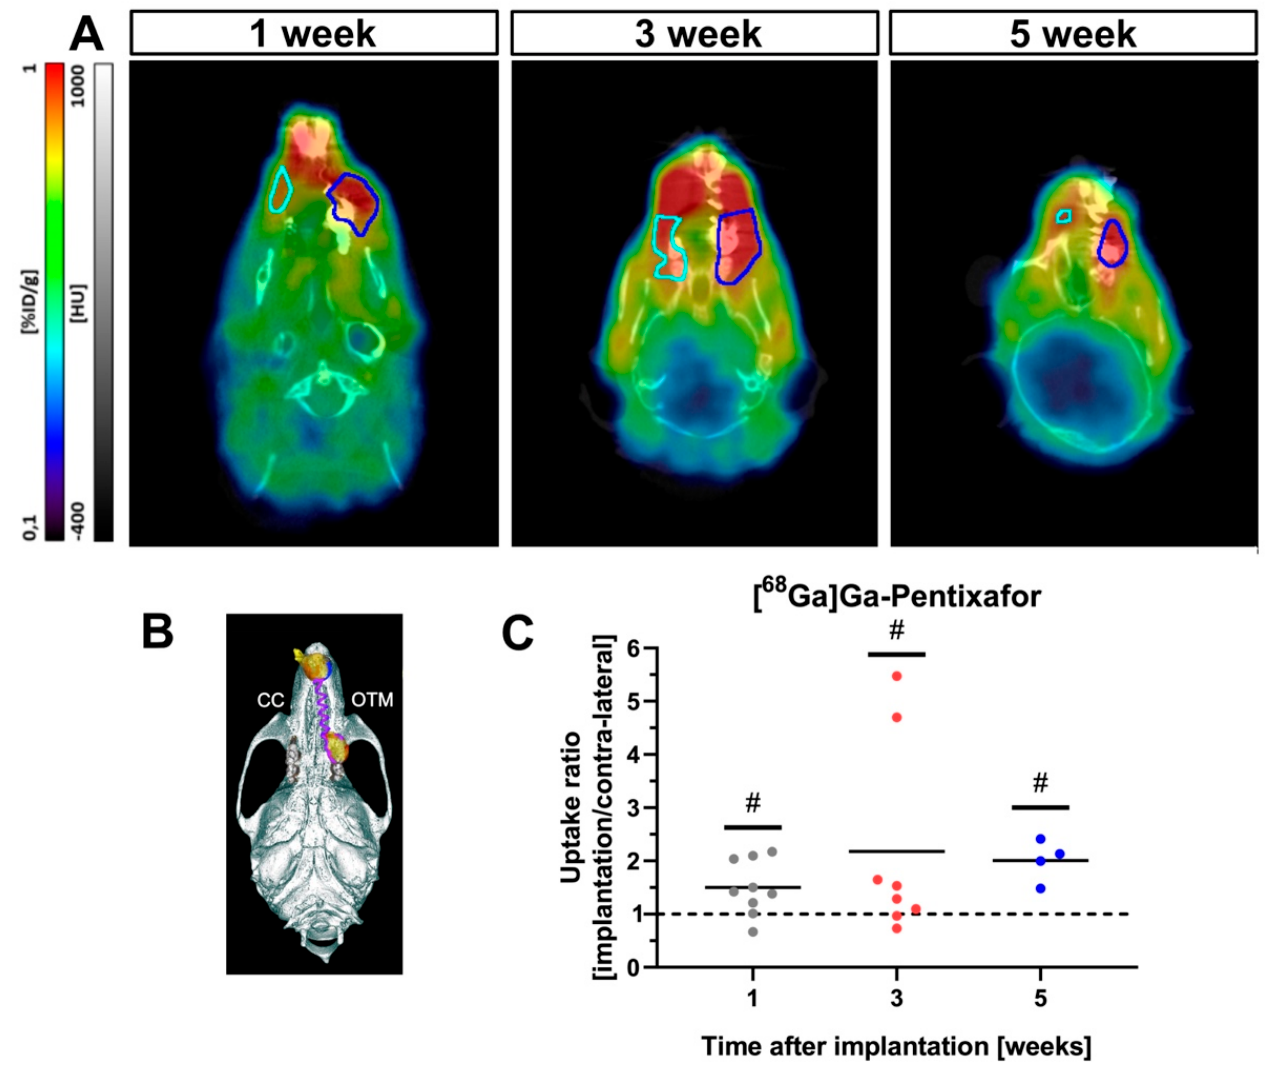
Figure 3. [ 68 Ga]Ga-Pentixafor uptake increases in the early and late phase of OTM. ( A ) A constant uptake of [ 68 Ga]Ga-Pentixafor was observed during the 5-week trial, suggesting a persisting presence of inflammation. The deep-blue contour represents the region of interest taken for the OTM side, while the turquoise one represents the contralateral side of the jaw, which was taken as a control. ( B ) OTM and control (CC) sides as revealed by the 3D rendering of the CT scan. ( C ) Significant differences of the uptake ratio were compared to 1 in the 1st and 5th weeks; the 3rd week also showed a significant difference compared to 1 as a result of the two animals with a TBR > 4. There are no differences of the TBR between the scanning weeks, suggesting a constantly increased uptake. #: statistically significant difference compared to